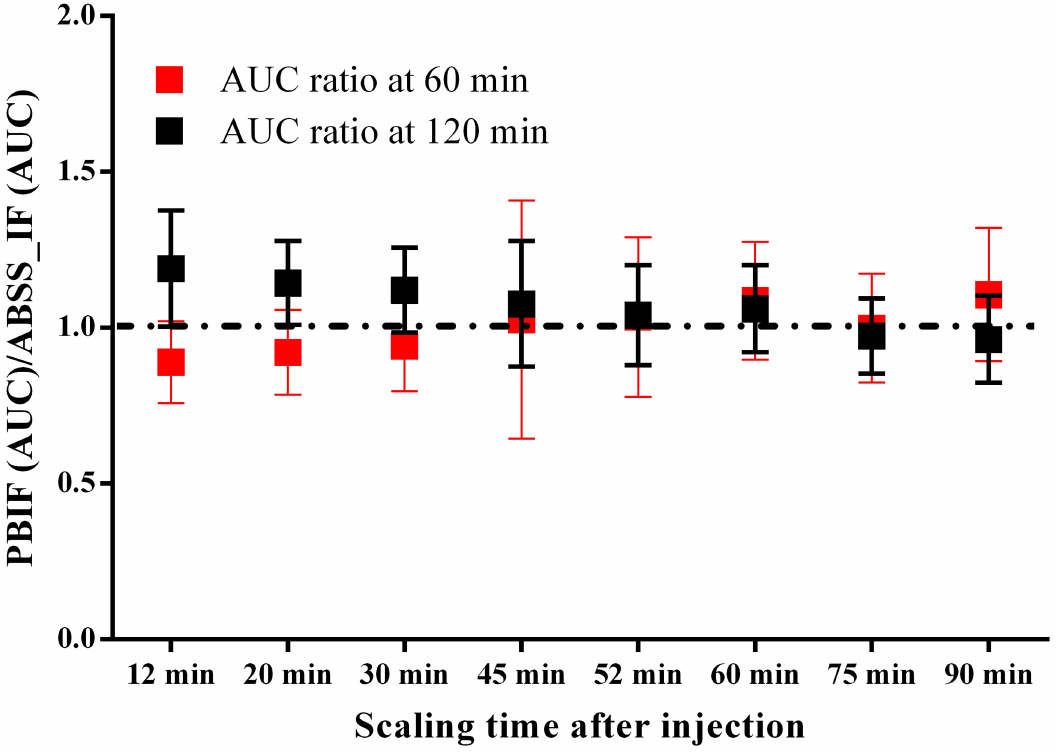
Fig 2. Comparison of the AUC of the PBIF and ASIF at 60 and 120 min as a function of the time-sample used to rescale. Samples at 75 min minimizethe difference and SD. It should be noted that sample at 52 min is the average between45and 60 min and 75 is the averagebetween60 and 90 min. the result is the averagebetween21 HC, 18 AD and 16